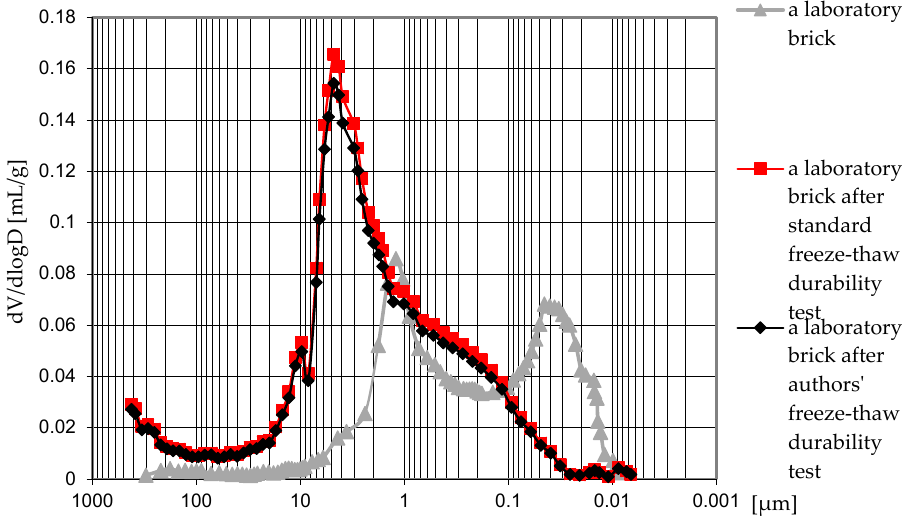
Figure 5. Differential curve of pore size distribution in test samples.